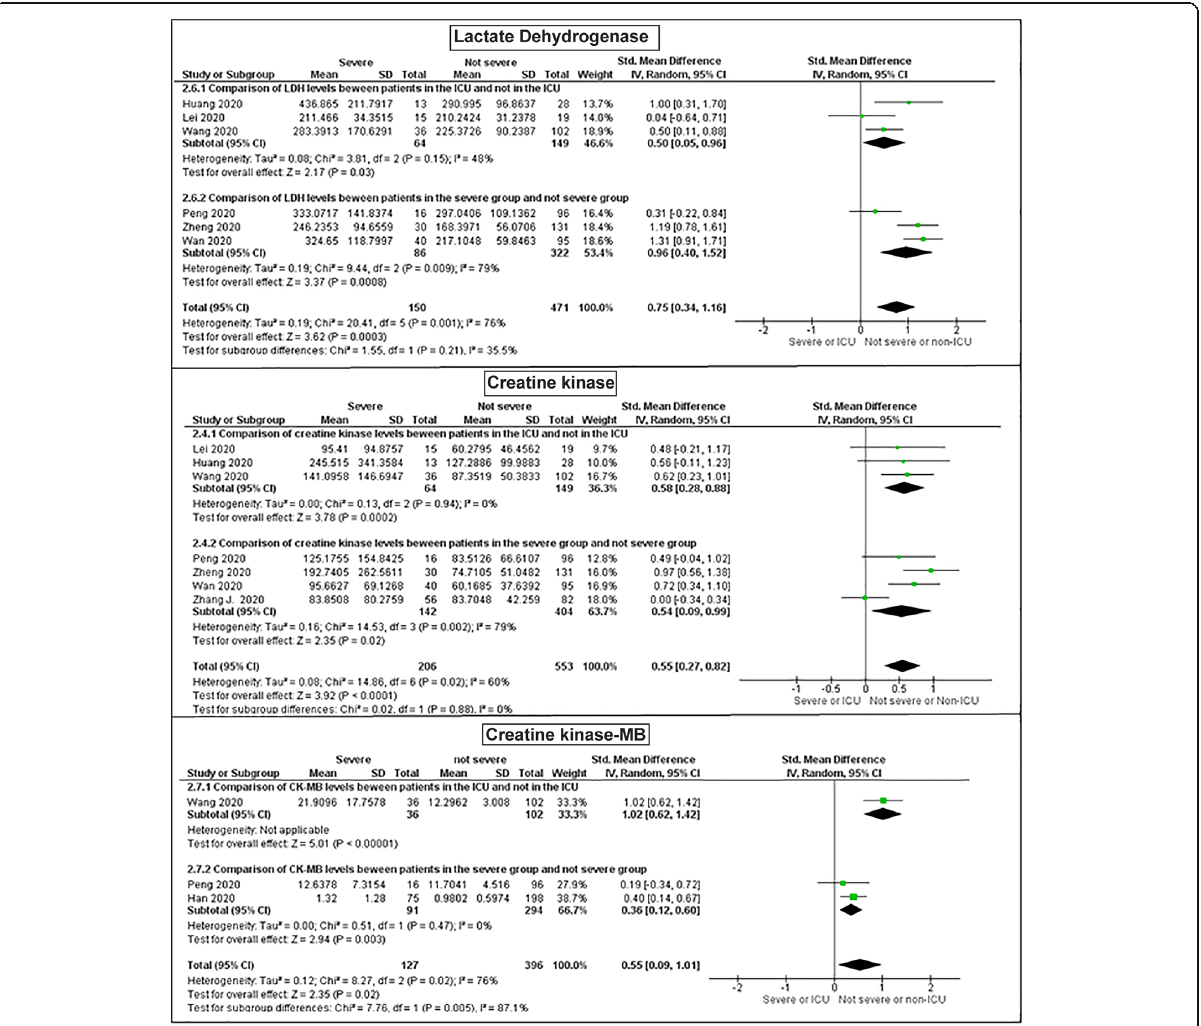
Fig. 7 Standard mean difference of LDH, CK and CK-MB between COVID-19 patients with severe disease in comparison with non-severe